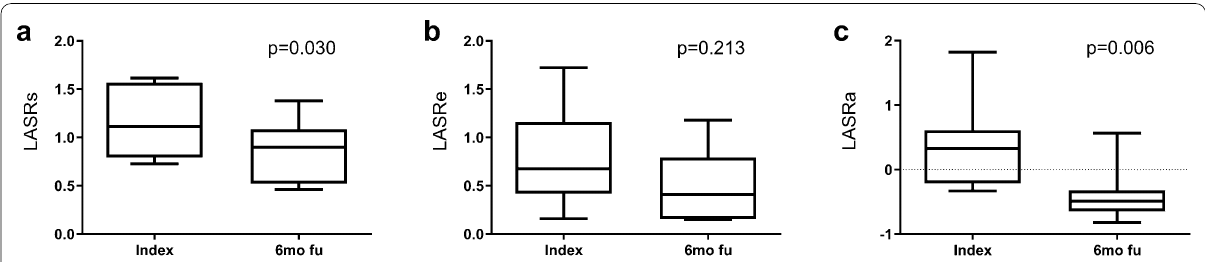
Fig. 3 LA Strain rate before and after ASD closure. a The mean global LA reservoir strain rate (paired t test), b The mean global LA conduit strain rate (Wilcoxon signed rank sum test), c The mean global LA contractile strain rate (paired t